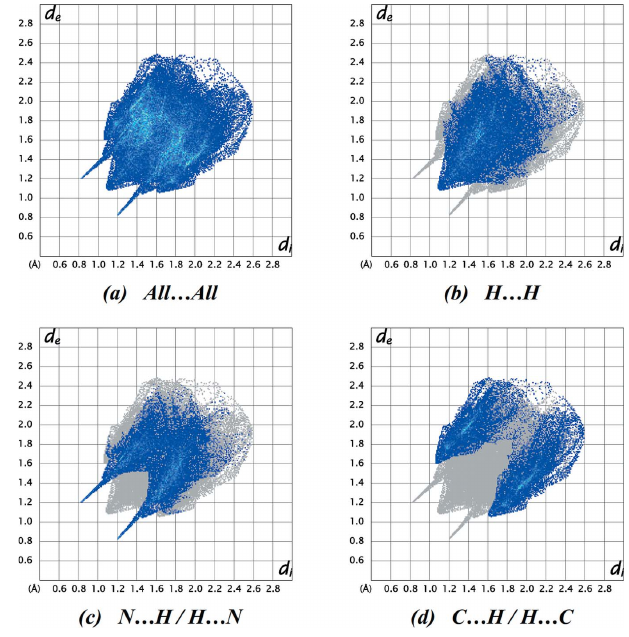
Figure 5 The two-dimensional fingerprint plots of the title compound, showing ( a ) all interactions, and delineated into ( b ) H (cid:2)(cid:2)(cid:2) H, ( c ) N (cid:2)(cid:2)(cid:2) H/H (cid:2)(cid:2)(cid:2) N, and ( d ) C (cid:2)(cid:2)(cid:2) H/H (cid:2)(cid:2)(cid:2) C interactions.